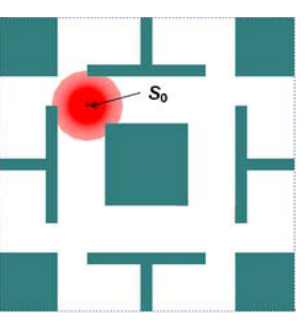
Figure 6. An initialized deployment area.